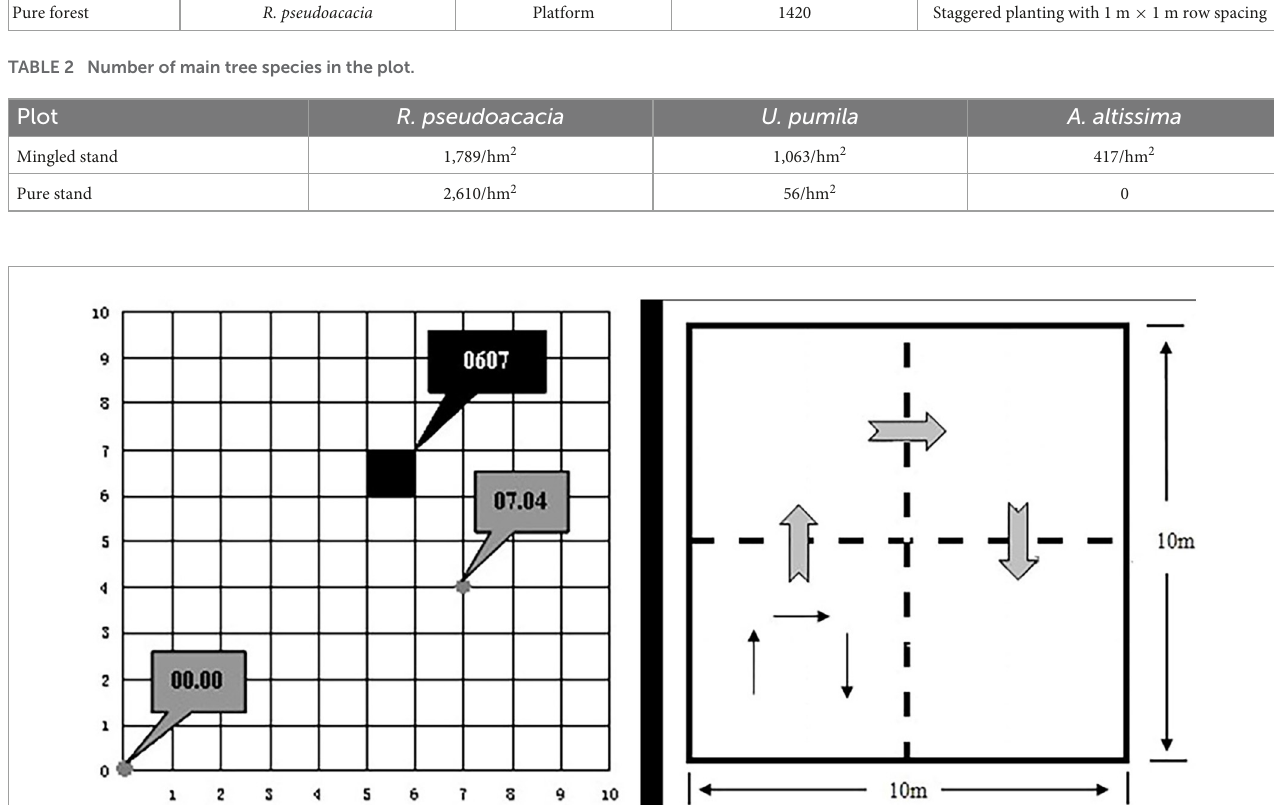
FIGURE3 Sample division and working order diagram. The left figure shows the schematic diagram of sample number, 0 is the origin, each small square is 10 m × 10 m, and the total is 100 m × 100 m. The right figure shows the schematic diagram of work order for each 10 m × 10 m sample.